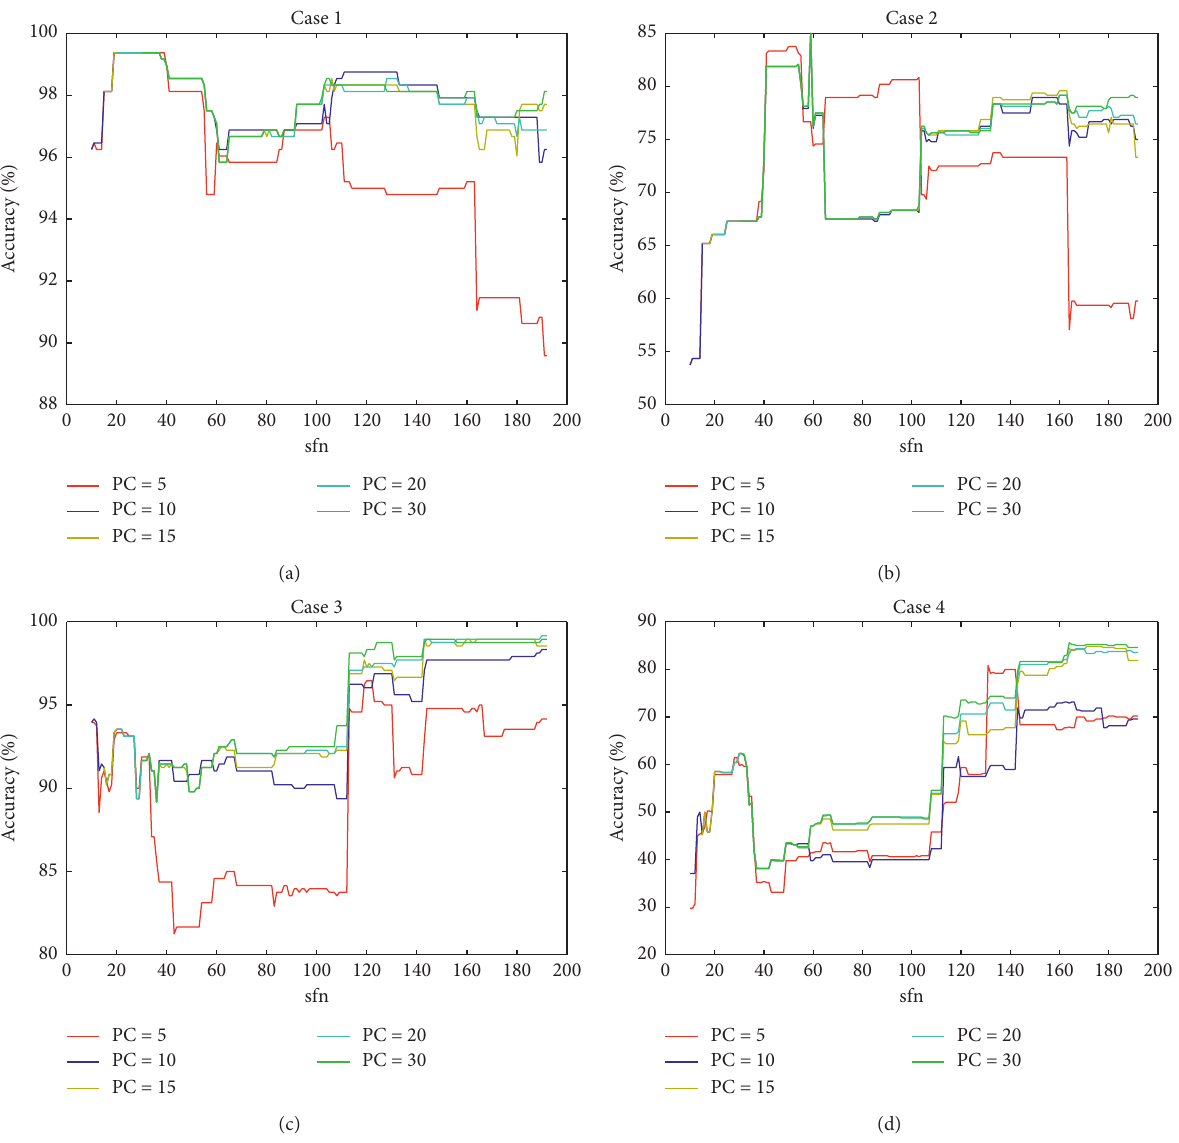
Figure 9: The curve representation of diagnosis results obtained by OFS-TSFRS-PCA-SVM using WPT with different dimension sizes for PCA. The PC represents the number of dimension